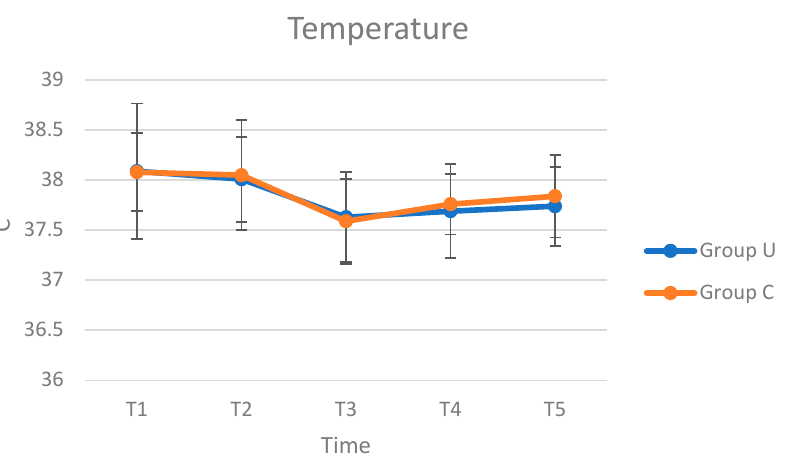
7 of 10 Figure 4. Average values of RR (apm), values in Group U (pigs underwent ultrasound